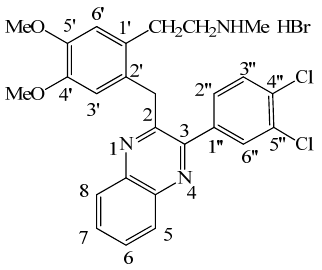
Figure 8. Chemical structure of compound 2d .